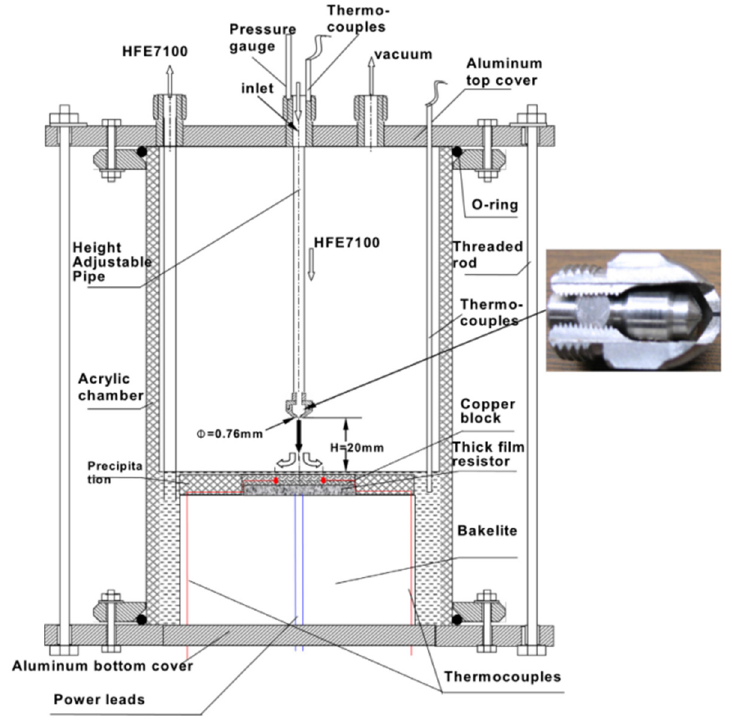
Figure 16. Schematic of jet impingement system [104].